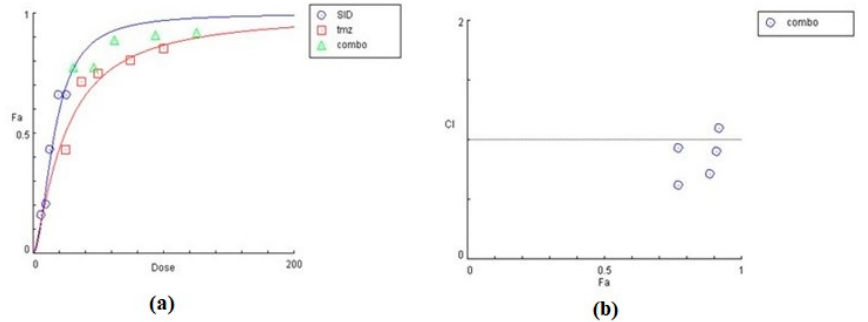
Figure 10. Graphical representation of the combinatorial effect of siderol and TMZ in U87 cell line, from CompuSyn Report. The dose-effect curve ( a ) for each substance, as for the combination of them. The x -axis represents the concentrations of substances and the y -axis the effect (% mortality). The Combination Index plot ( b ) represents the combinations where CI < 1, =1, or